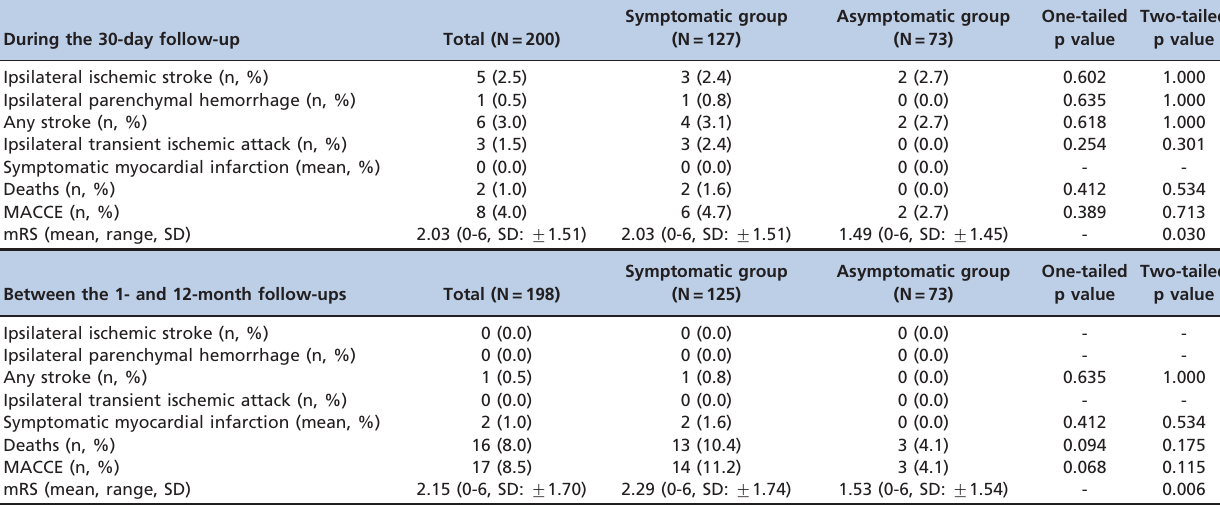
Table 4 - Clinical outcomes per group at the 1- and 12-month